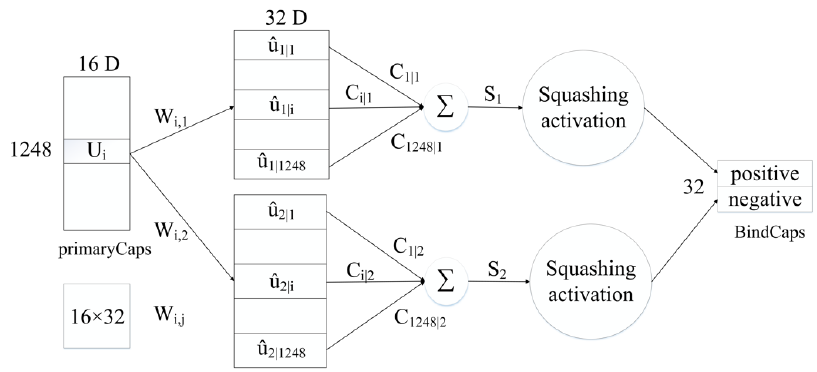
Figure 9. Routing calculation process between PrimaryCaps and BindCaps.